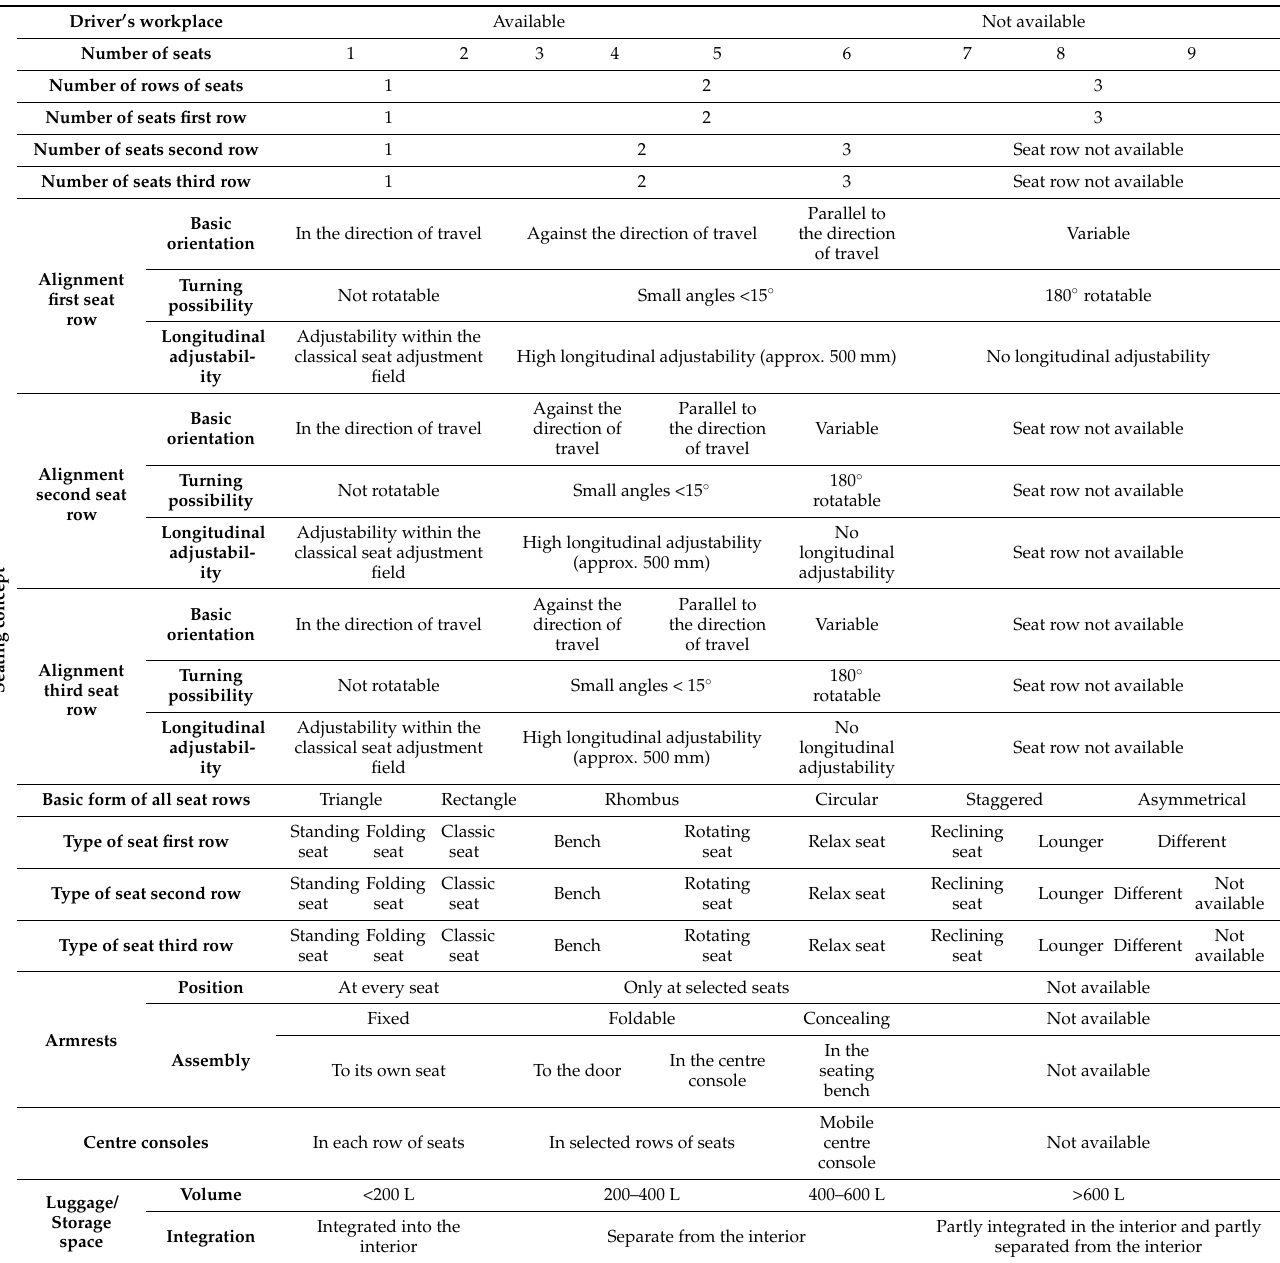
Table 2. The solution space of current and future seating concepts as a morphological box (own table based on Baumgartner [27]). Almost all available vehicles in Europe in 2021 were inspected for the